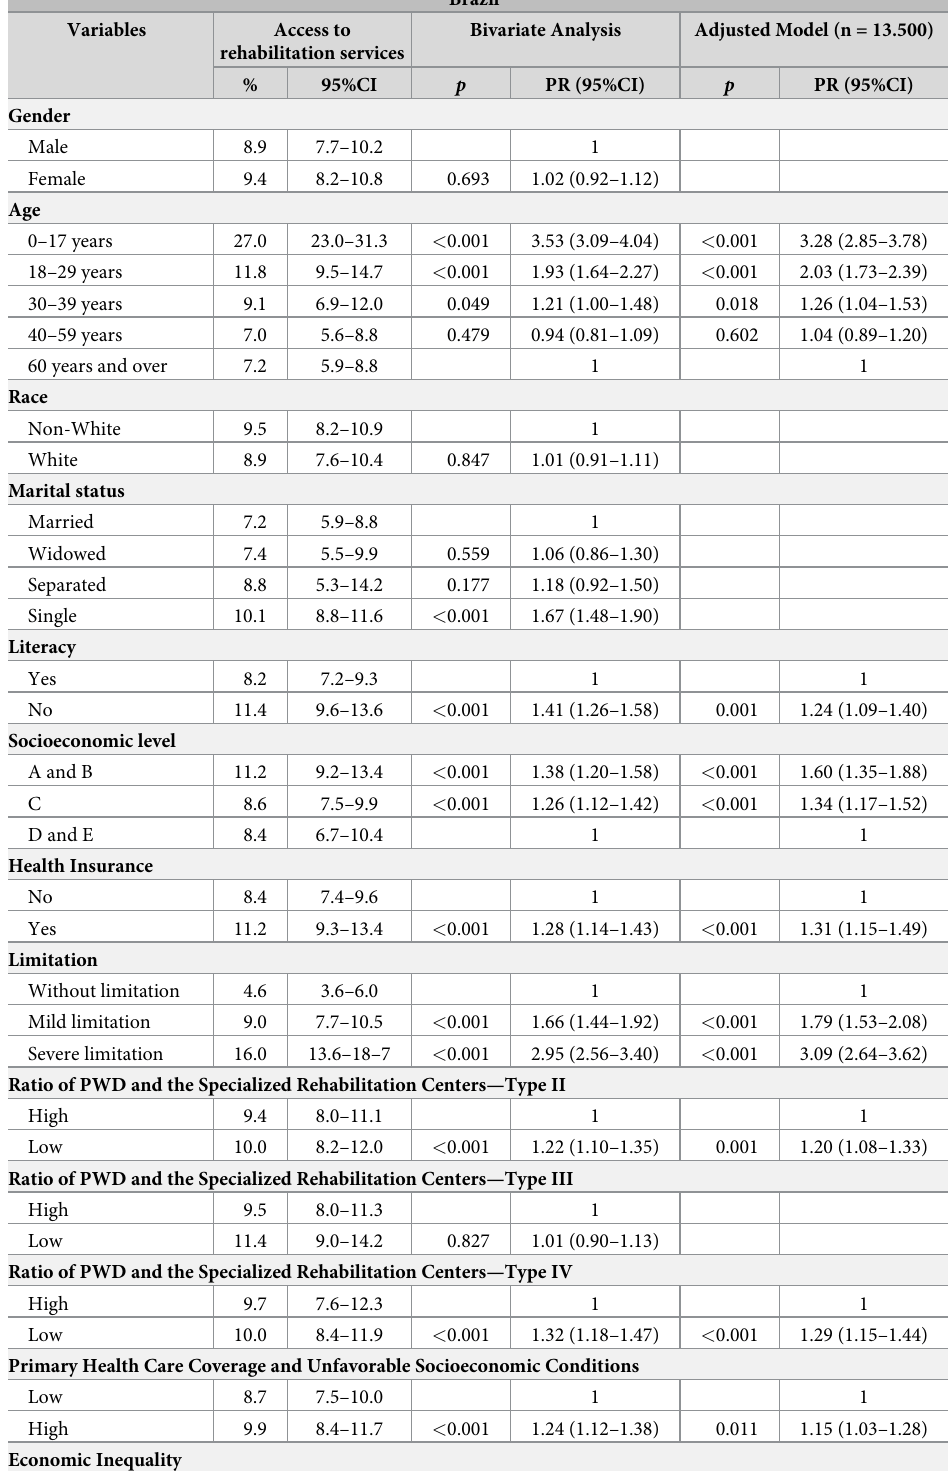
Table 4. Association between access to rehabilitation services for people with disabilities and independent vari- ables. Brazil,